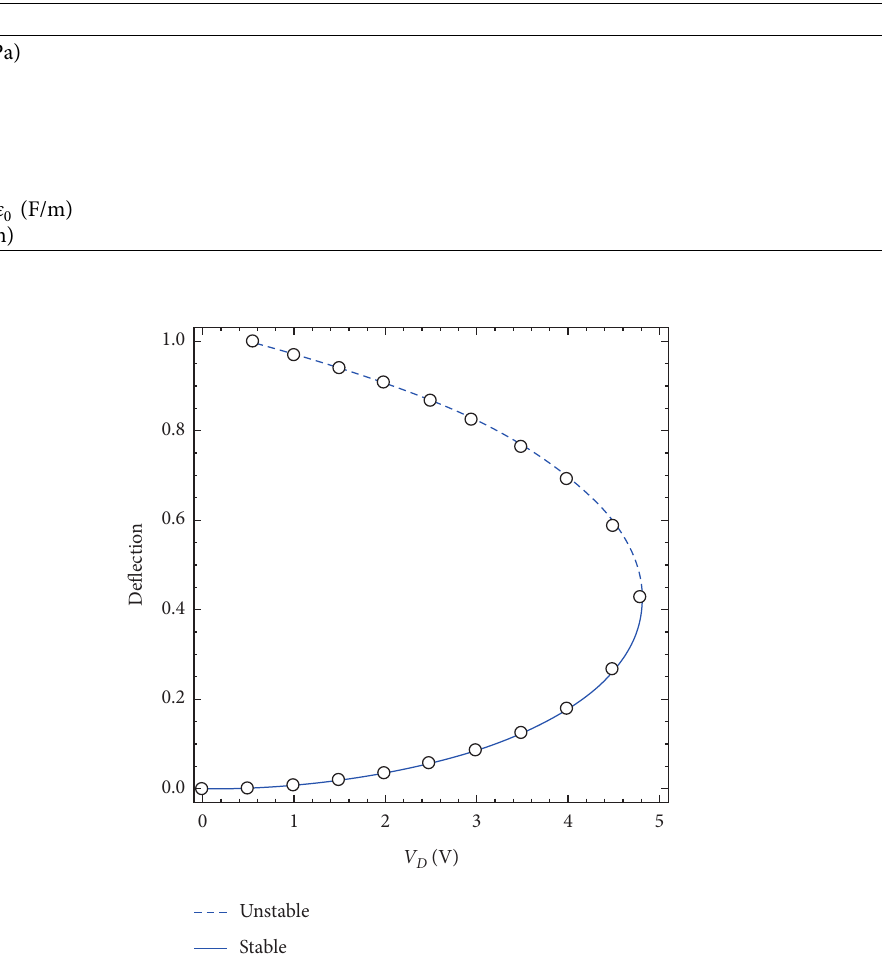
Table 1: Physical parameters of microbeam-based resonator [4].